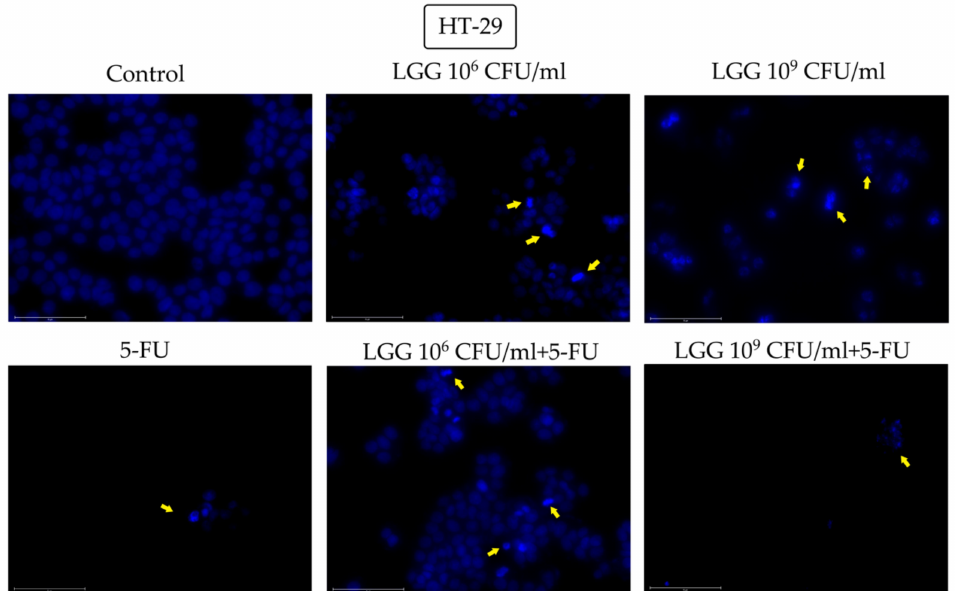
Figure 3. Nuclear morphological changes in HT-29 cells observed following 48 h treatment with LGG 10 6 and 10 9 CFU/mL, alone or in association with 10 µ M 5-FU. The yellow arrows represent signs of apoptosis (nuclear shrinkage, fragmentation, condensation, and cellular membrane disruption). The scale bar is 75 µ